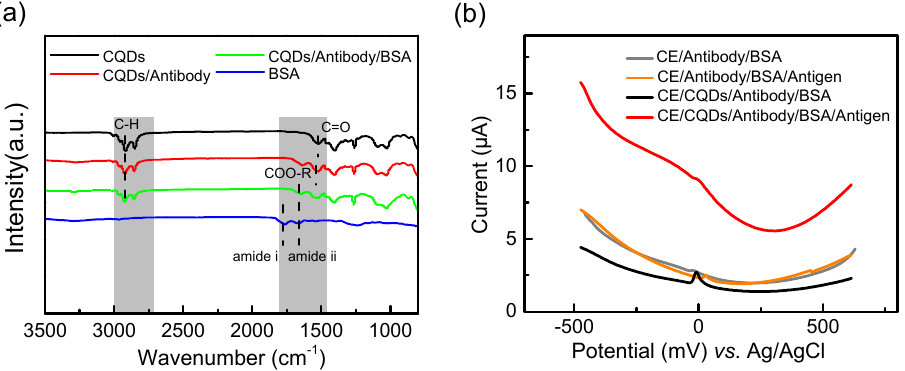
Figure 3. ( a ) FTIR spectra of CQDs, CQDs/Antibody, CQDs/Antibody/BSA and BSA; ( b ) Performance comparison of sensors with CQDs and without CQDs.